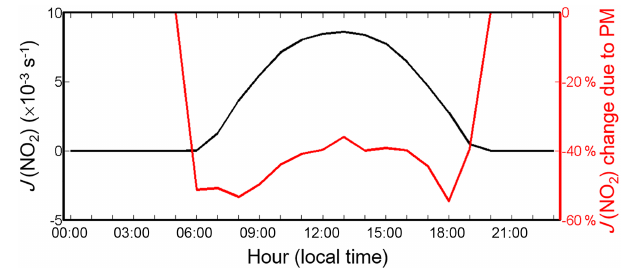
Figure 6. Diurnal variations of J (NO 2 ) (black) and the changes in J (NO 2 ) (red) averaged in urban Xi’an due to PM effects in Au- gust